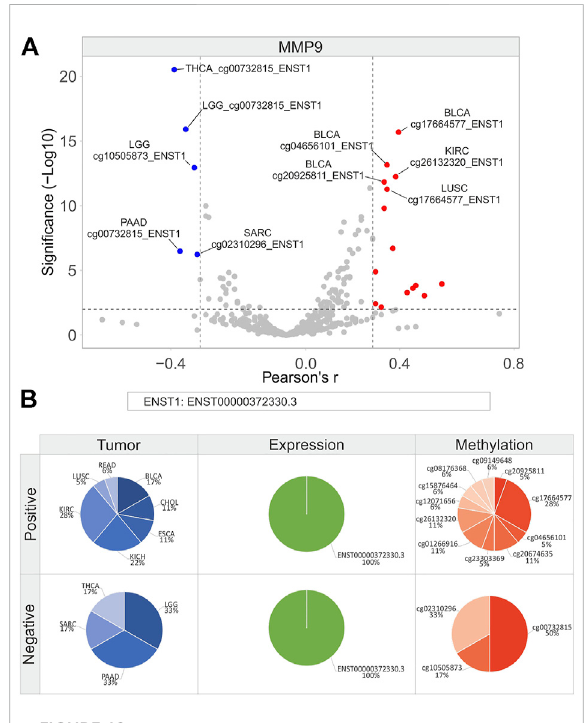
FIGURE 12 Correlation analysis between MMP9 isoforms expression and relative CG probesets methylation levels in each tumor type. (A) Volcano plot showing the correlation between CG probesets and isoforms expression of MMP9 (Pearson ’ s r ≥ 0.3 and ≤ − 0.3, p ≤ 0.01). The top ten hits ( fi ve positive and fi ve negative) based on correlation signi fi cance are labeled. Blue dots: negative correlation, red dots: positive correlation. (B) Percentage of tumor types, gene/isoforms and CG probesets showing Pearson ’ s r ≥ 0.3 and ≤ − 0.3 ( p ≤ 0.01), separately. No more than ten variables with the highest correlation values are